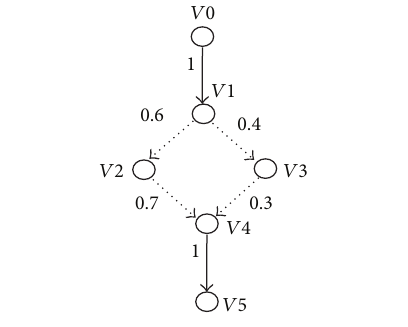
Algorithm 1 first calls the function Aggregate ( 𝐴𝑇, 𝐴𝑃